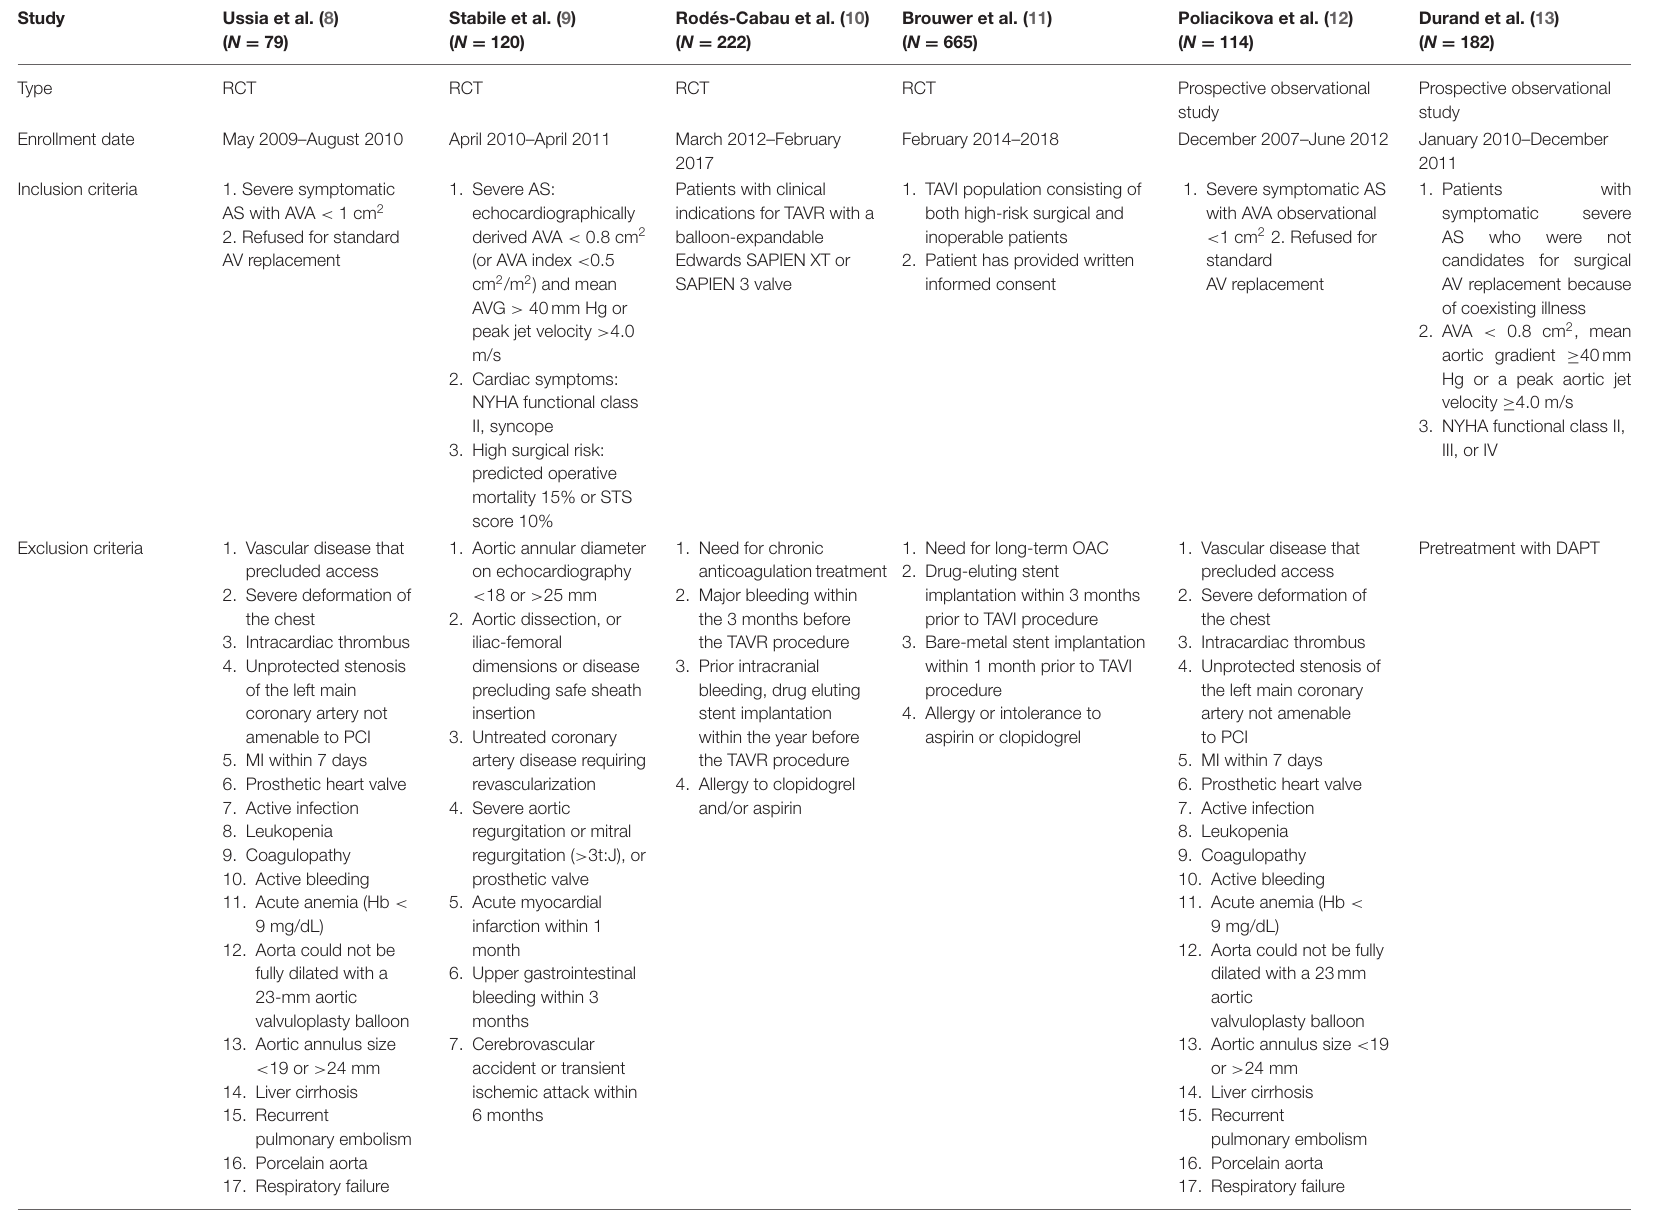
TABLE 1 | Characteristics of included